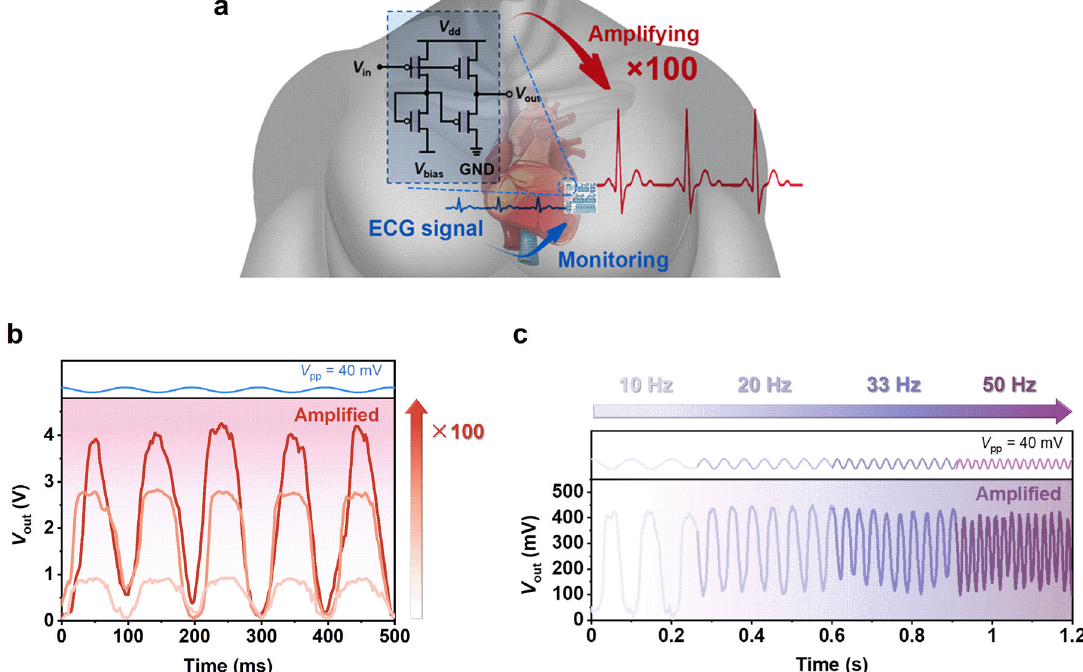
Fig. 7 Ampli fi er for ECG monitoring. a Illustration of the ECG monitoring using an analog ampli fi er made of the intrinsically fl exible ACNT circuits. b Output signals of the ampli fi er showing as many as 100 times of signal ampli fi cation ( V pp = 40 mV, V dd = 1, 3, and 5 V). c Ampli fi er output with various input signal frequencies of 10 – 50 Hz ( V dd = 0.5